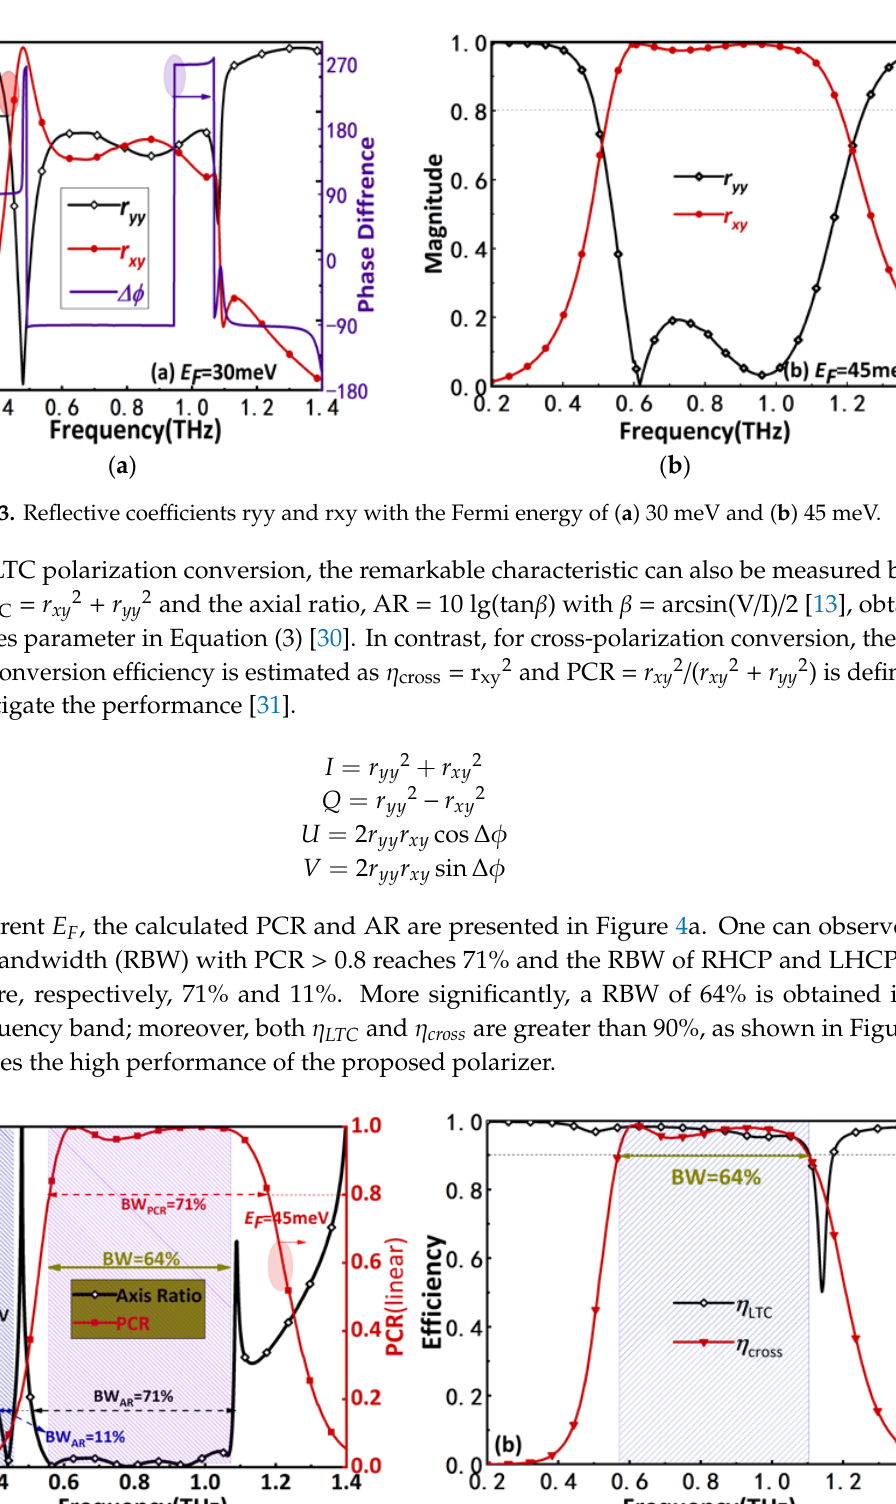
Figure 4. ( a ) AR and PCR and ( b ) efficiencies.